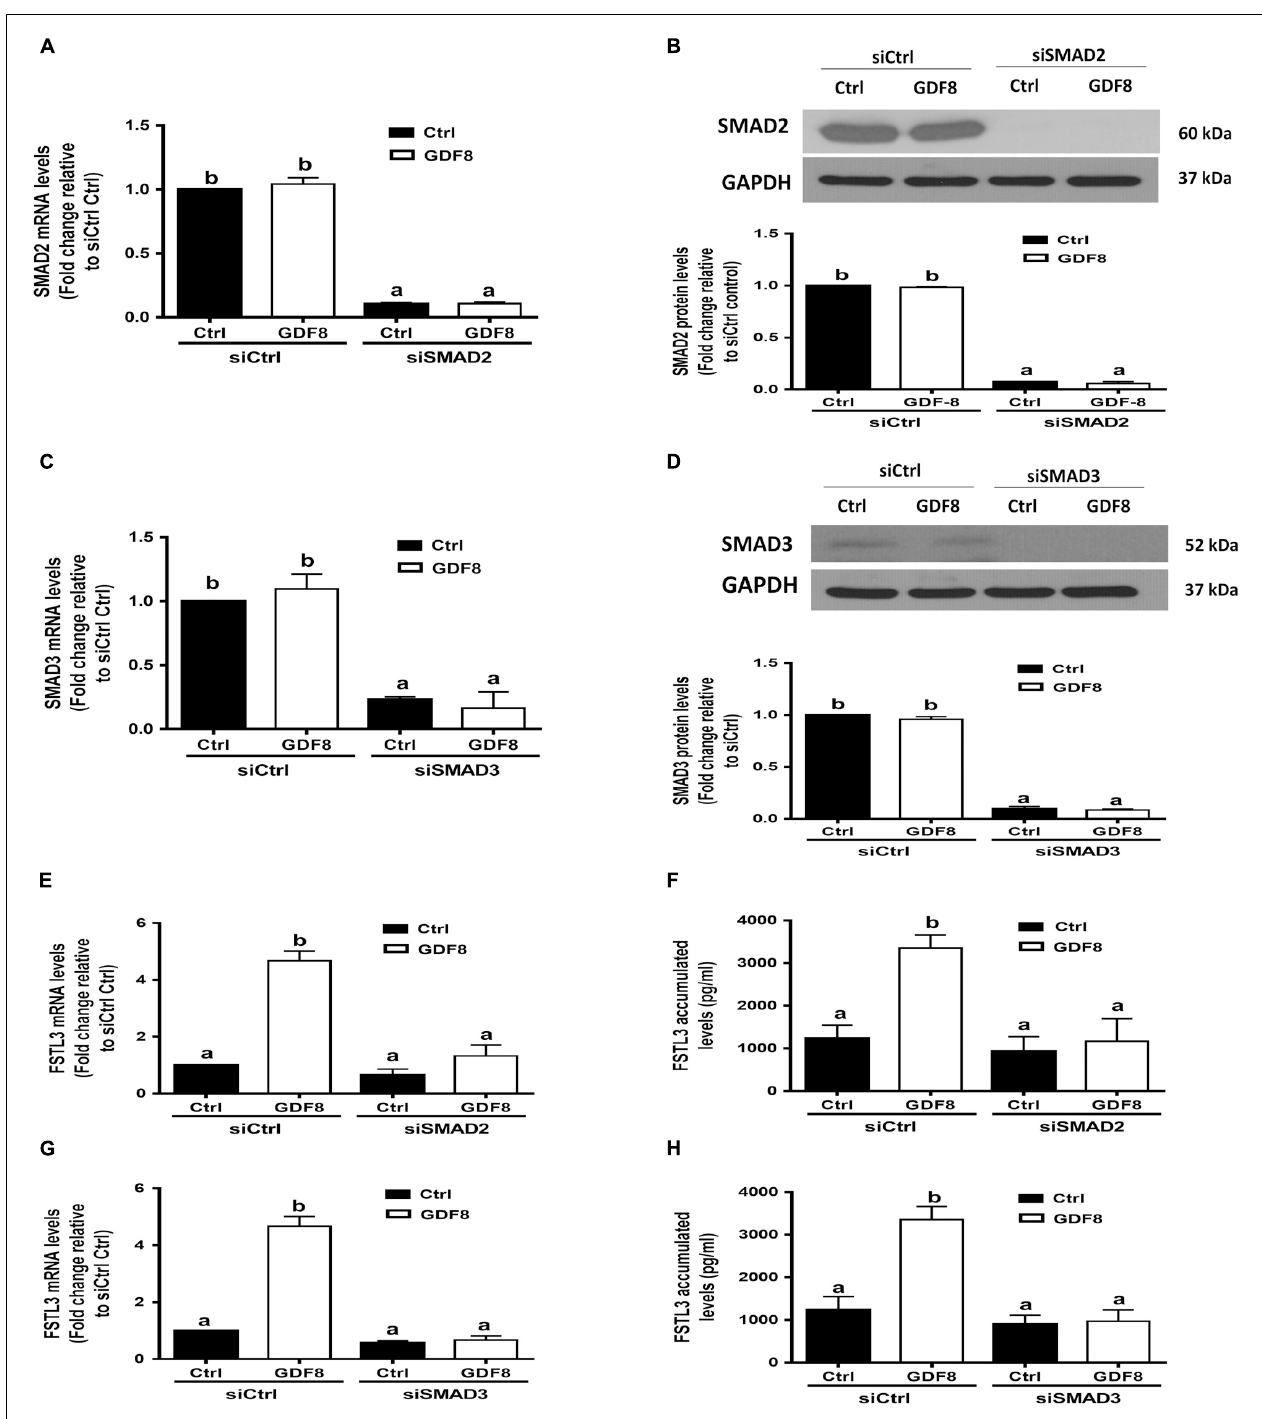
FIGURE 6 | SMAD2 and SMAD3 are the downstream mediators of the growth differentiation factor 8 (GDF8)-induced upregulation of follistatin-like 3 (FSTL3) expression in HTR8/SVneo cells. (A–D) HTR8/SVneo cells were transfected for 24 h with 20 nM non-targeting control siRNAs (siCtrl), 20 nM siRNAs targeting SMAD2 (siSMAD2) or 20 nM siRNAs targeting SMAD3 (siSMAD3), after which the cells were treated with the vehicle control (Ctrl) or 25 ng/mL GDF8 for 24 h; the mRNA and protein levels of SMAD2 (A,B) and SMAD3 (C,D) were examined using RT-qPCR and western blot analysis, respectively. (E–H) HTR8/SVneo cells were transfected for 24 h with 20 nM siCtrl, 20 nM siSMAD2 (E,F) or 20 nM siSMAD3 (G,H) , after which the cells were treated with the vehicle control (Ctrl) or 25 ng/mL GDF8 for 24 h; the mRNA (E,G) and accumulated (F,H) levels of FSTL3 were examined using RT-qPCR and ELISA, respectively. GAPDH used as the loading control and a reference for densitometric analysis for SMAD2 and SMAD3. The results are displayed as the mean ± SEM of at least three independent experiments, and the values with different letters are significantly different ( P < 0.05).